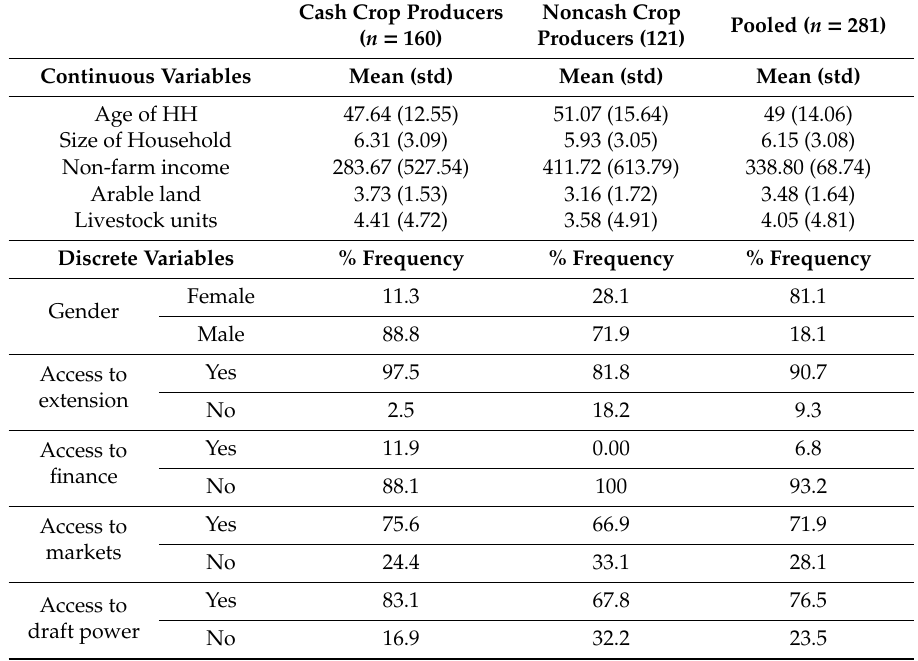
Table 2. Socio economic characteristics of farming households in Shamva District, Zimbabwe. HH: household